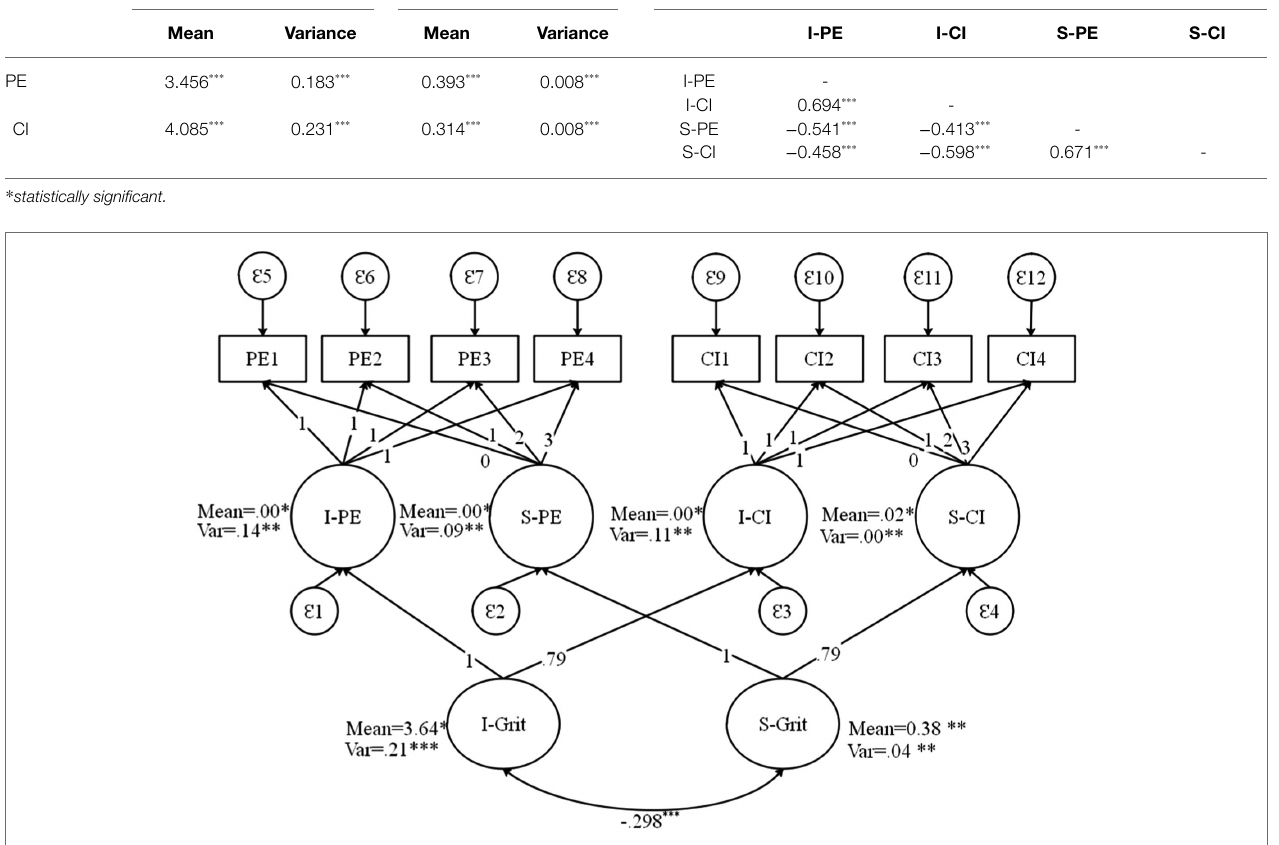
TABLE 2 | Results of the parallel process model (PPM). Intercept factors